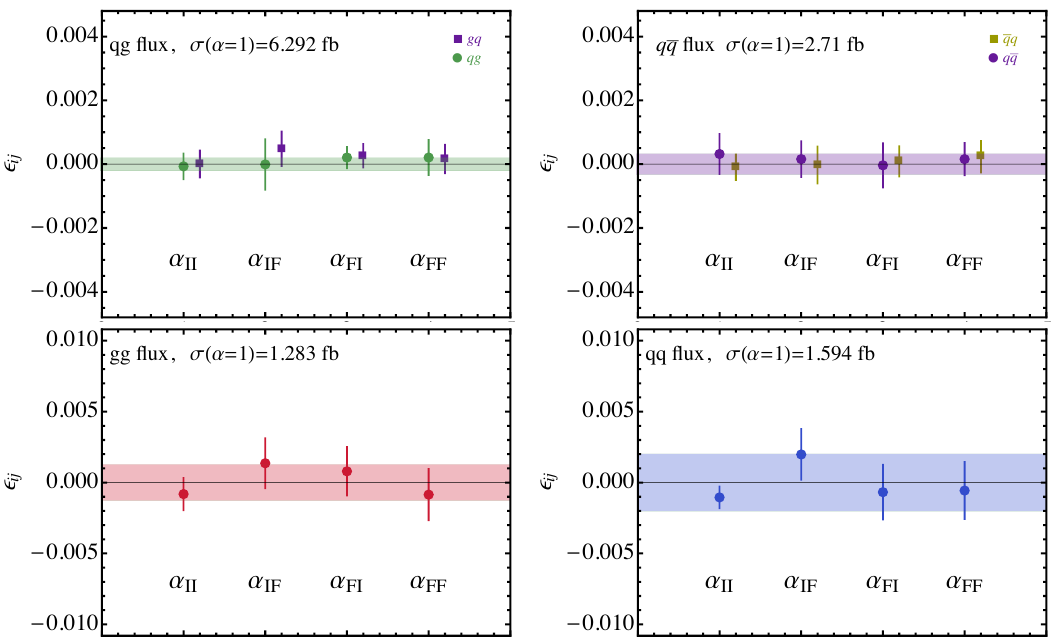
Figure 4 . The independence on the α parameter for a selection of partonic configurations for bottom-induced H + 2 j production. The shaded band indicates the uncertainty on the α = 1 prediction. The most intricate qg and qq channels, which receive contributions from both bbggH and four-quark amplitudes, have been computed with greater Monte Carlo